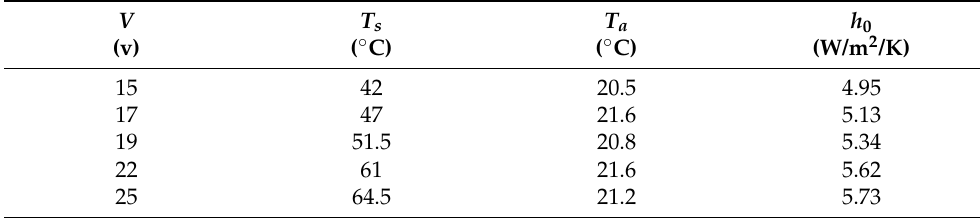
Table 4. Analytical analysis results excluding the radiation phenomenon.